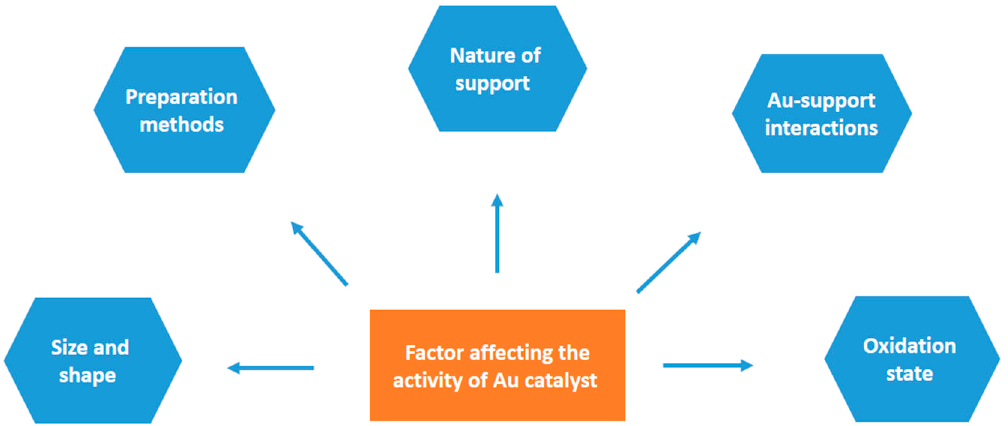
ff ecting the catalytic activity of gold Figure 3. Factors affecting the catalytic activity of gold catalysts. Figure 3. Factors a